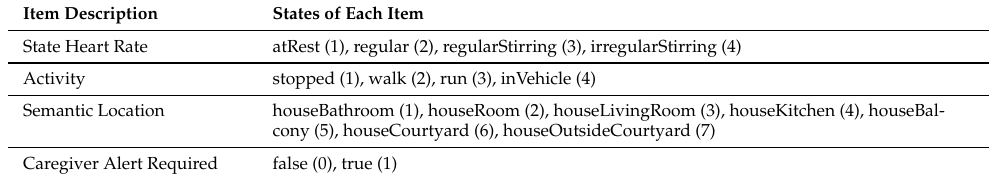
Table 5. DCARE Dataset Simulator dictionary structure data.